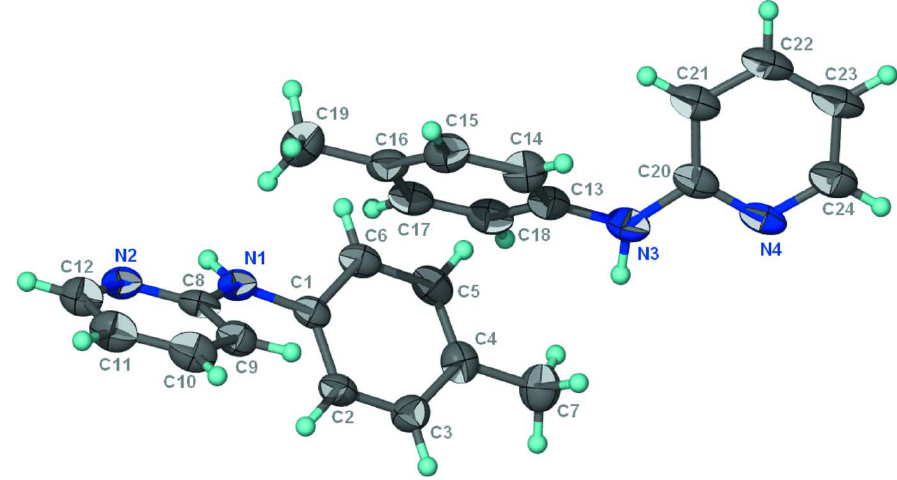
Figure 1 The molecular structure of (I), with displacement ellipsoids at the 70% probability level; hydrogen atoms are drawn as spheres of arbitrary